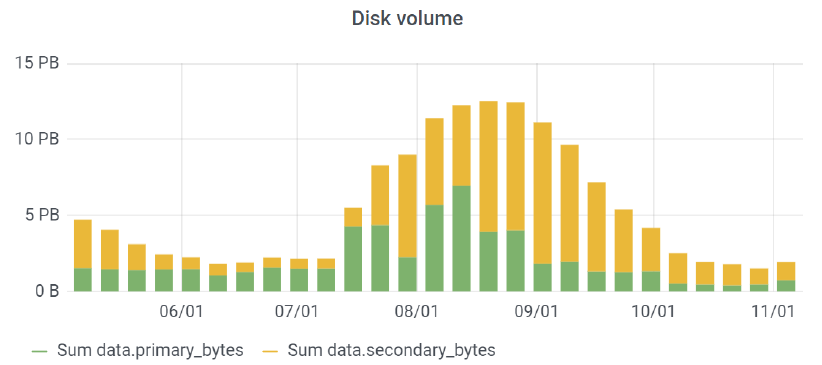
Figure 3: RAW data volume on disk. Primary RAW data sample in green, secondary data in yellow. Secondary data are ready to be deleted when disk space is needed. It shows full Figure 1: Total Tier-1 staging throughput (GB / s) during the reprocessing campaign.